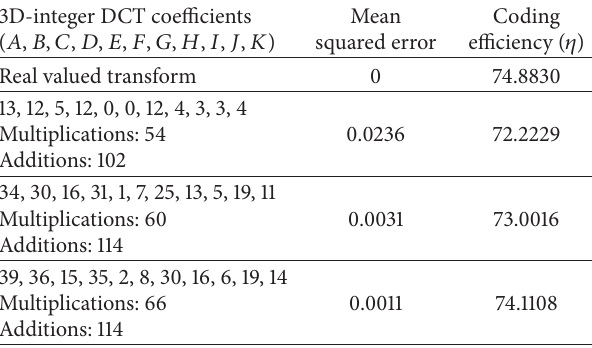
Table 1: MSE and coding efficiency of 3D-integer DCT computed via WHT. 3D-integer DCT coefficients